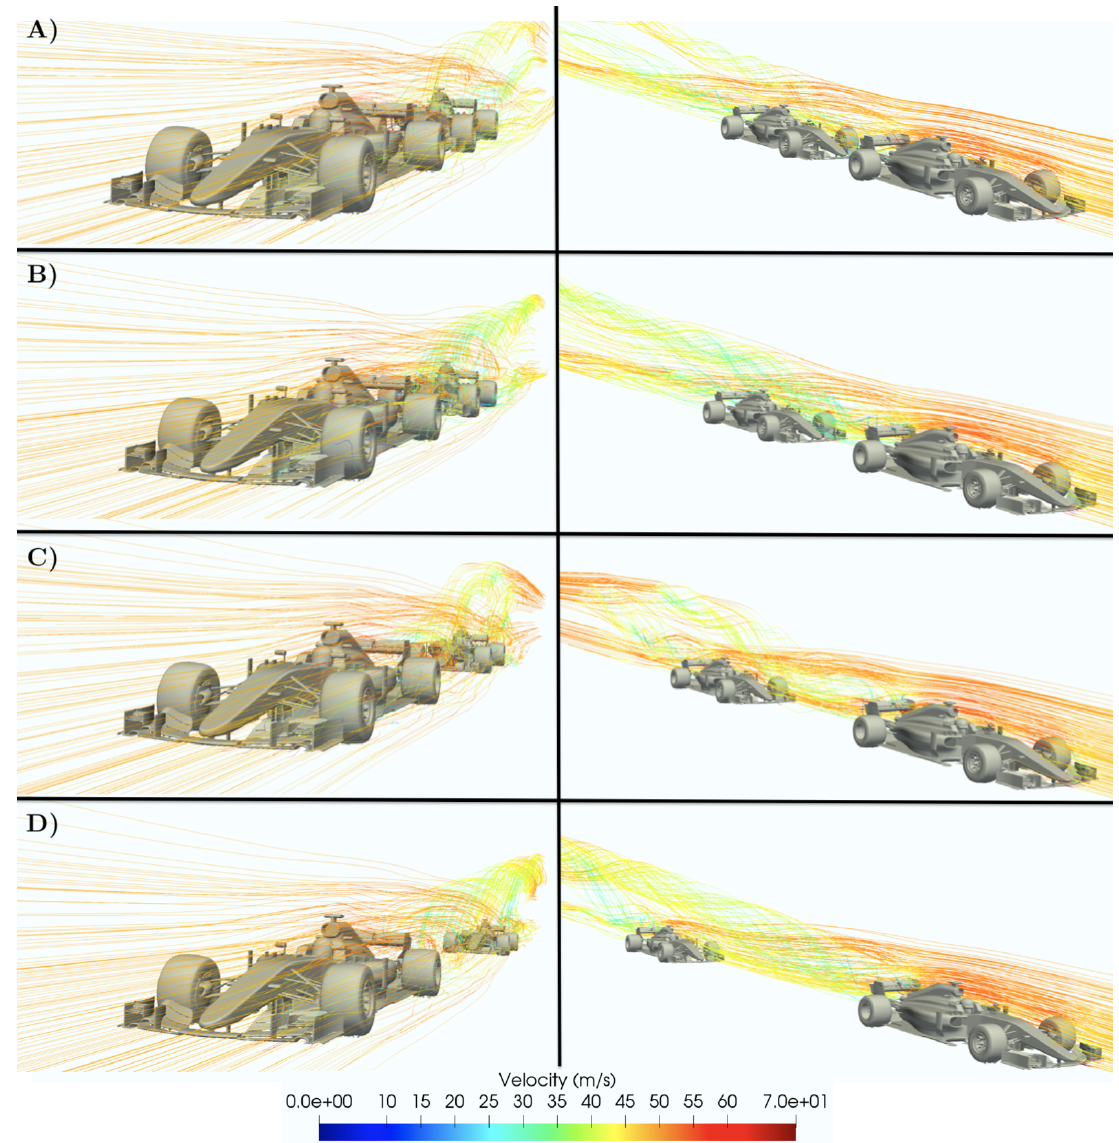
Figure 25. Streamlines of the velocity at a distance of ( A ) 0.25 L, ( B ) 0.5 L, ( C ) 1 L, and ( D ) 2